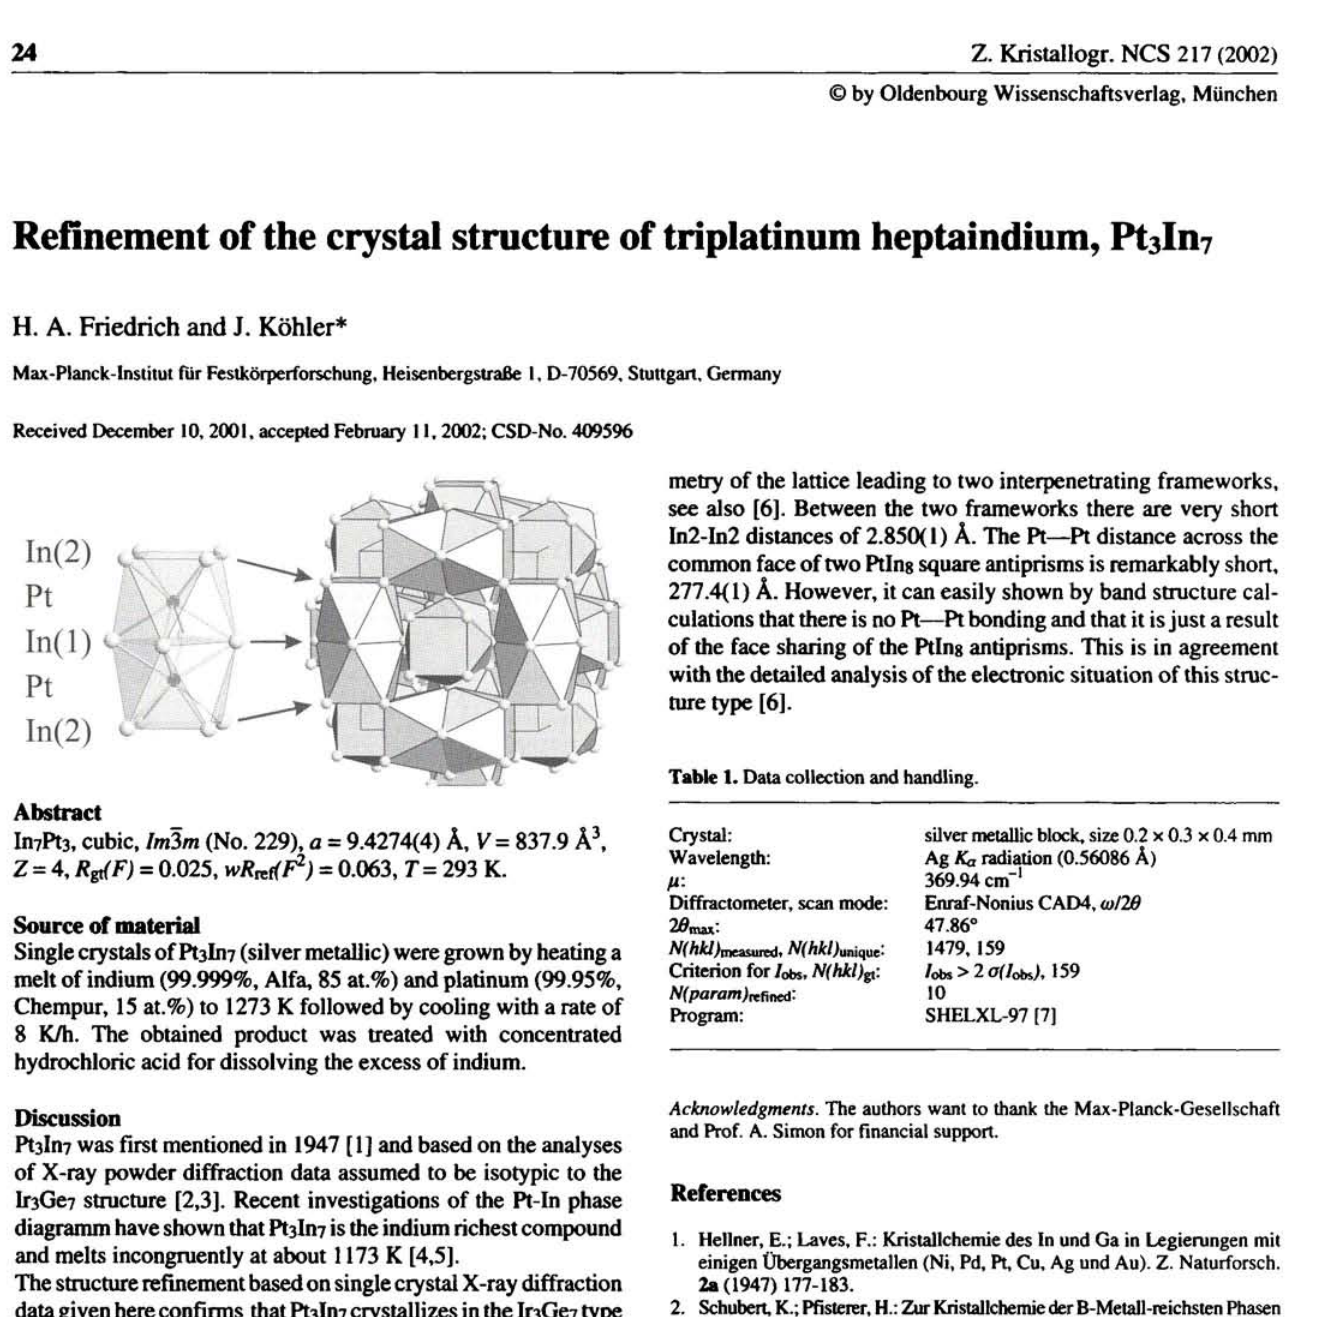
Table 2. Atomic coordinates and displacement parameters (in Â 2 ).